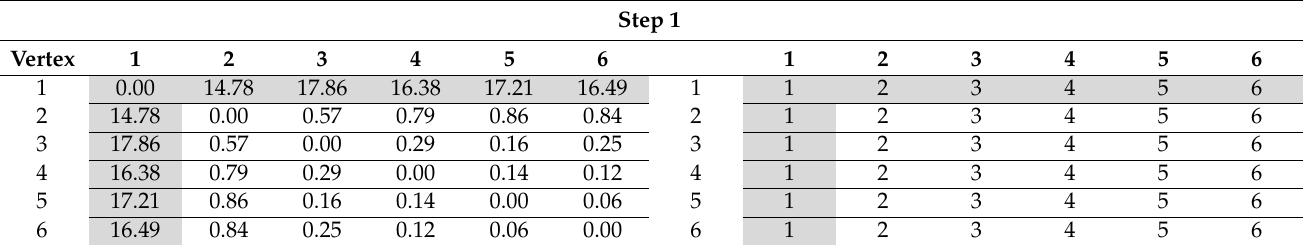
Table A1. The step 1 graphical process of Floyd–Warshall algorithm.